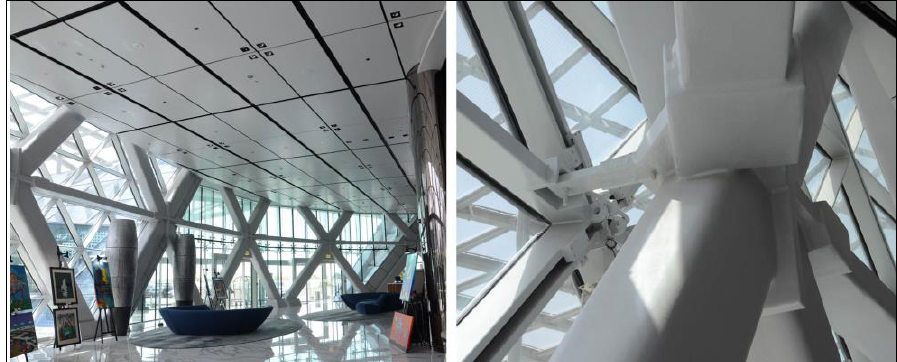
Figure 20. Capital Gate Tower: Diagrid structure—view from the interior (photograph by authors).